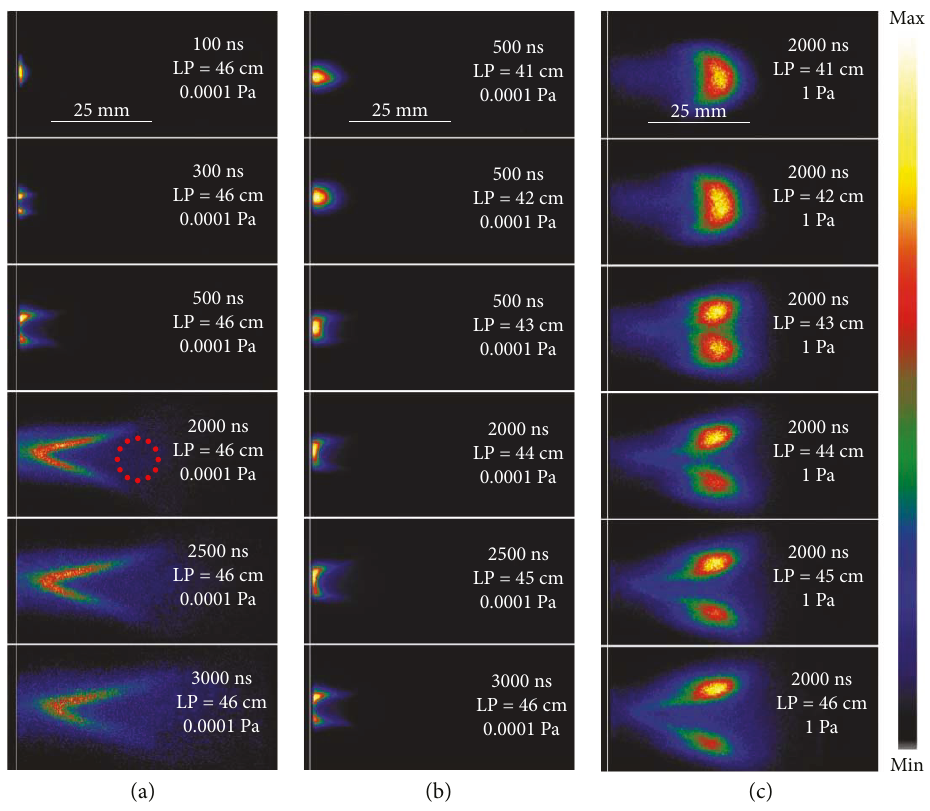
Figure 3: Images of the V-like plasma shape obtained for LP =46cm at various stages of time evolution (a), comparison between visible radiating shapes obtained for various laser beam focusing at 500ns delay (b), and drag e ff ect observed for expansion in ambient gas